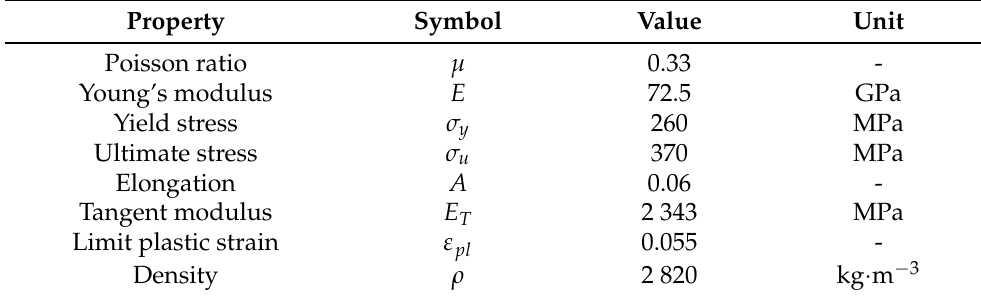
Table 2. Material constants of AW2011